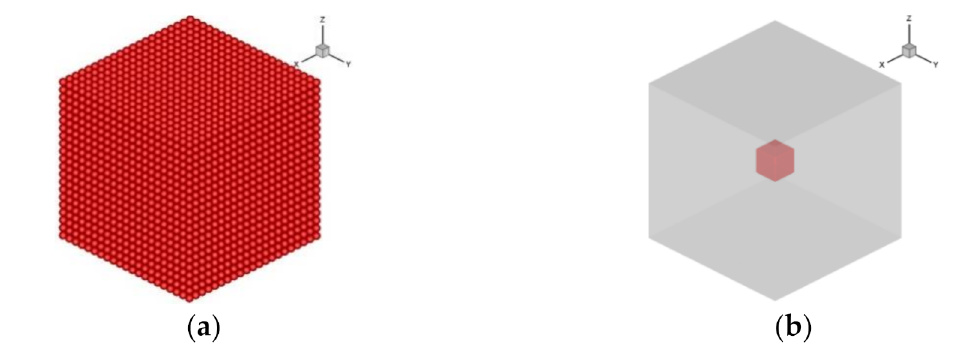
Figure 7. The computational model: ( a ) 1 m cubic fluid patch of MPS; ( b ) 7 m cubic air/1 m cubic water zone of VOF.